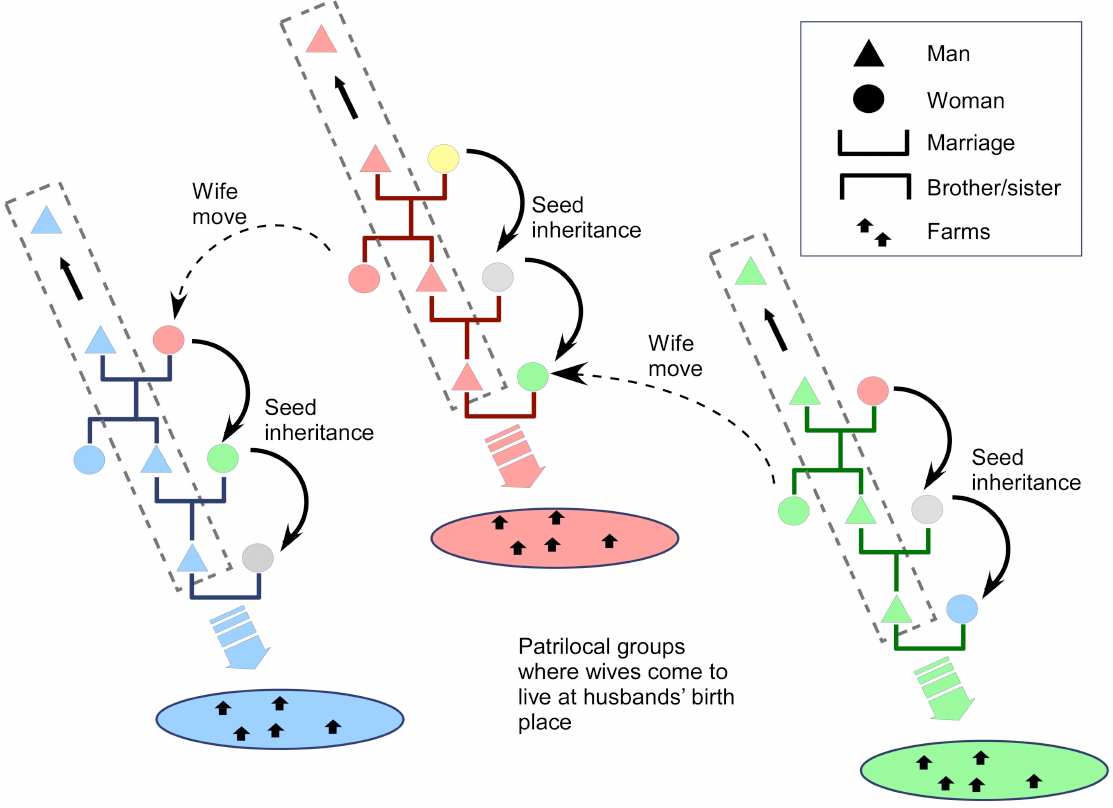
Figure 3. Vertical transmission of seeds in Muthambi communities on Mount Kenya. Colors represent different clans. Those communities are characterized by patrilineal filiation i.e. men live in the clan they were born and wives leave their own clan to join that of their husband when they get married. Wives establish their first fields with sorghum seeds traditionally obtained from their mother-in-law. It follows that the founding germplasm remains in the same residential group over generations, thus contributing genetic adaptation to the local